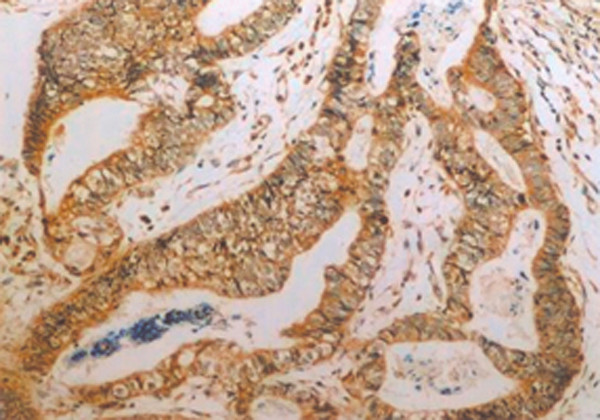
Positive control of VEGF expression. Samples used as the positive control of VEGF expression reported by Shibusa.